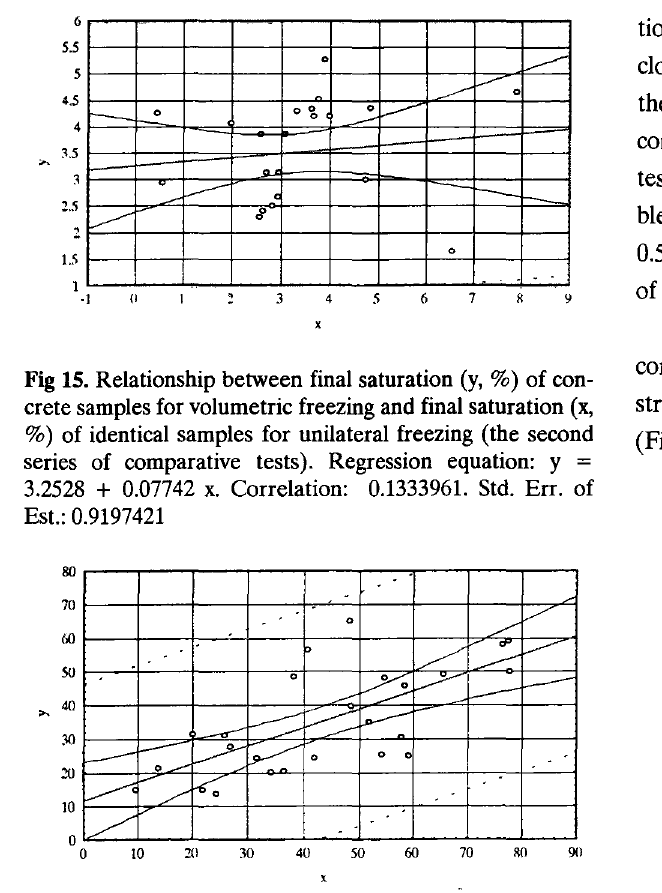
Fig 16. Relationship between compressive strength (y, MPa) of concrete samples for volumetric freezing and compres sive strength (x, MPa) of identical samples for unilateral freezing (the second series of comparative tests). Regres sion equation: y = 11.588 + 0.54207x. Correlation: 0.6846461. Std. Err. of Est.: 11.58108